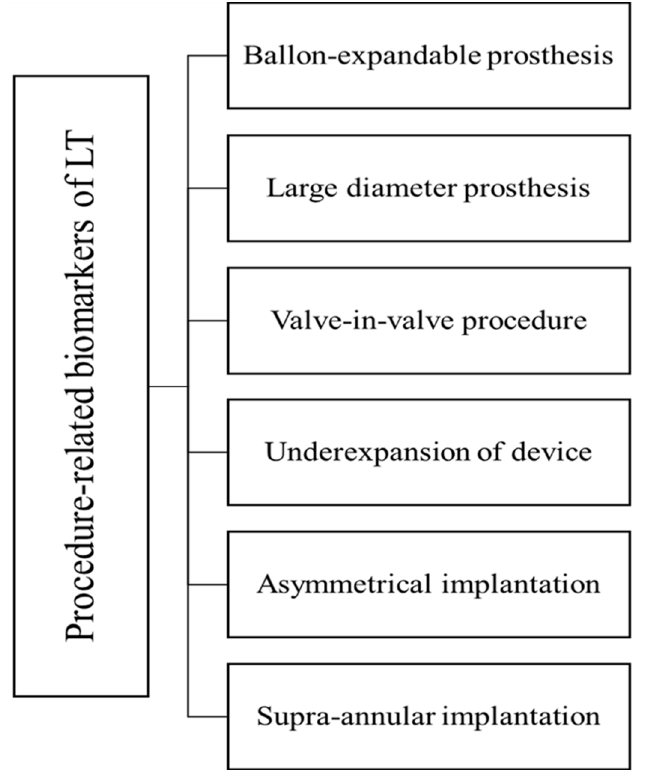
Figure 1. Procedural characteristics predisposing to leaflet thrombosis (LT) after transcatheter aortic valve implantation.